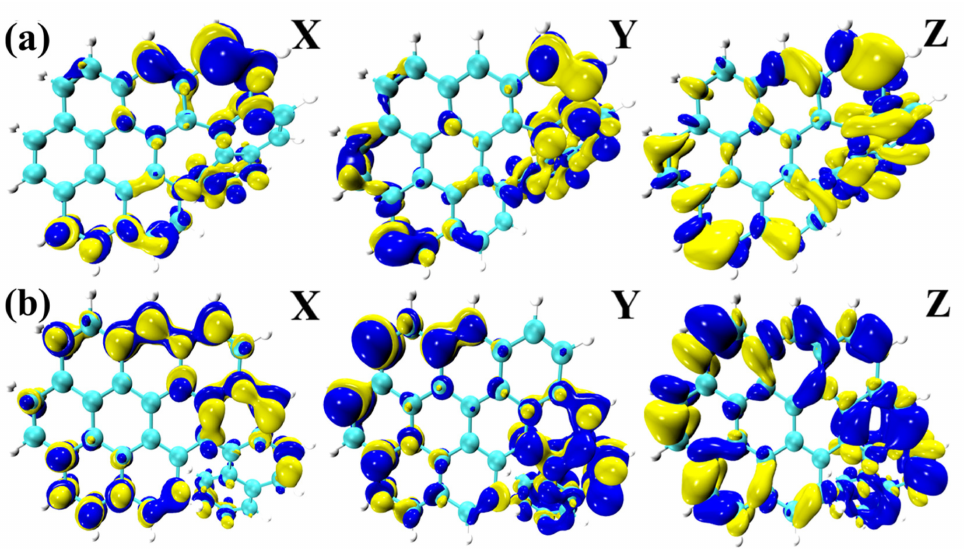
Figure 7. The Cartesian component isosurfaces of the transition magnetic dipole moment of the molecule (yellow and blue isosurfaces): ( a ) S 3 of OO8H and ( b ) S 5 of